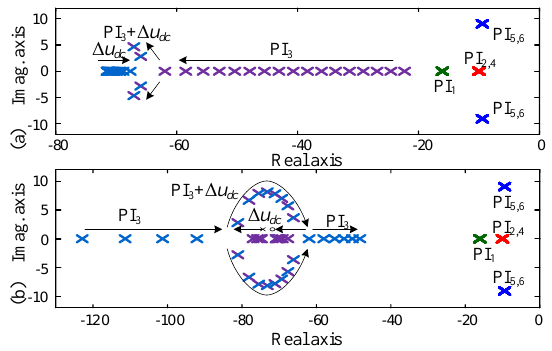
Figure 12. Root loci of the small-signal model. ( a ) k p 3 = 1.3 and k i 3 changes from 50 to 140; ( b ) k i 3 = 130 and k p 3 changes from 0.3 to 2.0.